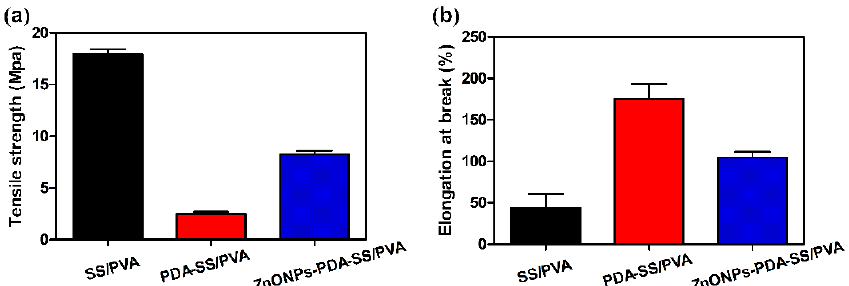
Figure 6. Mechanical properties of the films: ( a ) tensile strength and ( b ) elongation at break ( n = 3 per group).